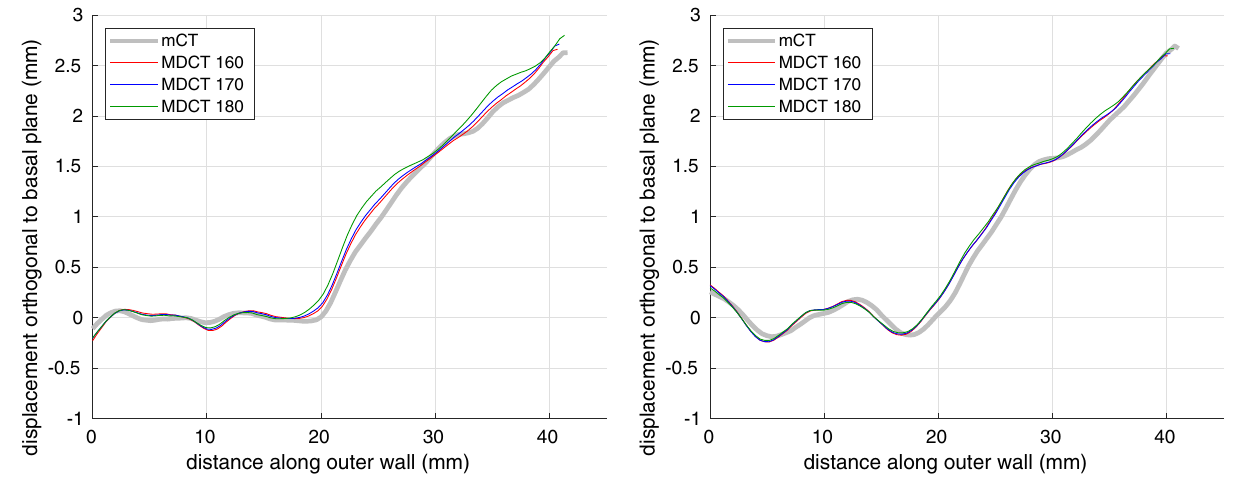
Figure 6. Vertical trajectories of the least (left) and most (right) nonplanar cochleas. The gold-standard micro-CT profiles are displayed in gray. The other profiles are derived from LAD model fits to the standard pseudo-clinical MDCT data, thresholded at 160 (red), 170 (blue) and 180 (green).